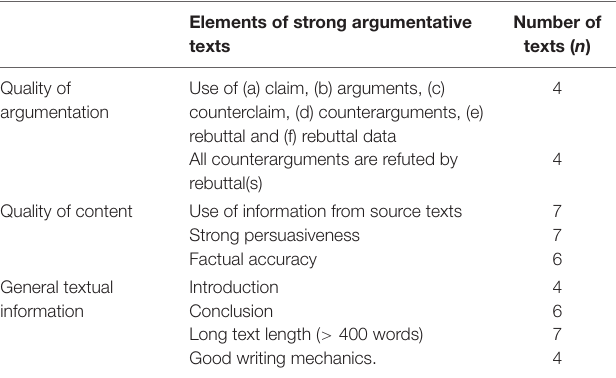
TABLE 12 | Elements of strong argumentative